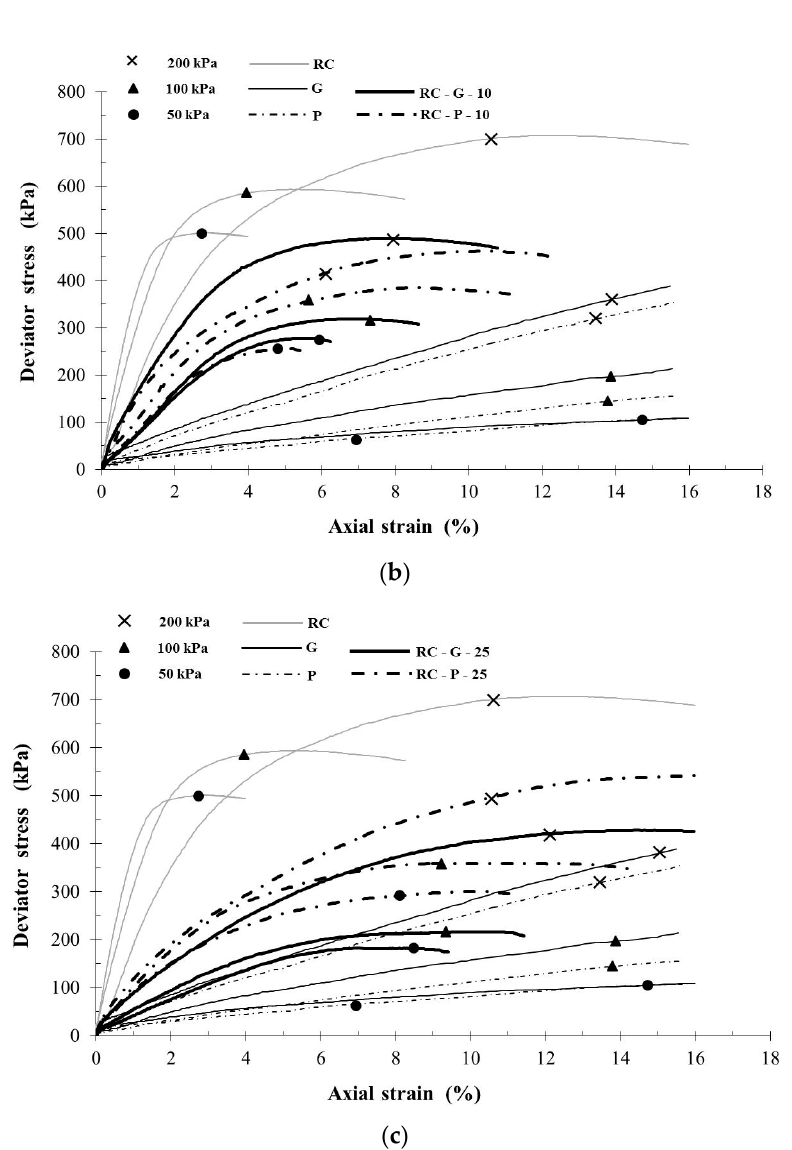
Figure 6. Deviator stress versus axial strain for pure red clay, powder and granulate, and for RCR mixtures, under confining pressure 50, 100, and 200 kPa: ( a ) 5% addition of (P) or (G), ( b ) 10% addition of (P) or (G), and ( c ) 25% addition of (P) or (G).